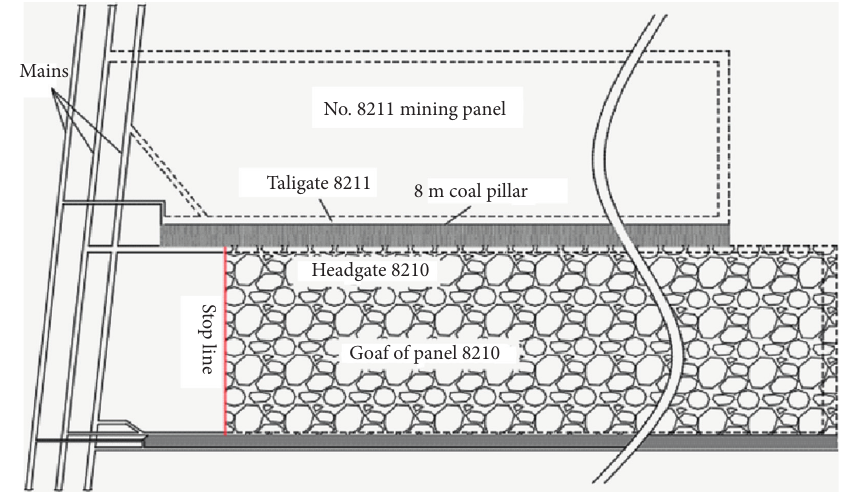
Figure 1: Diagram of the gob-side entry in section 8211.